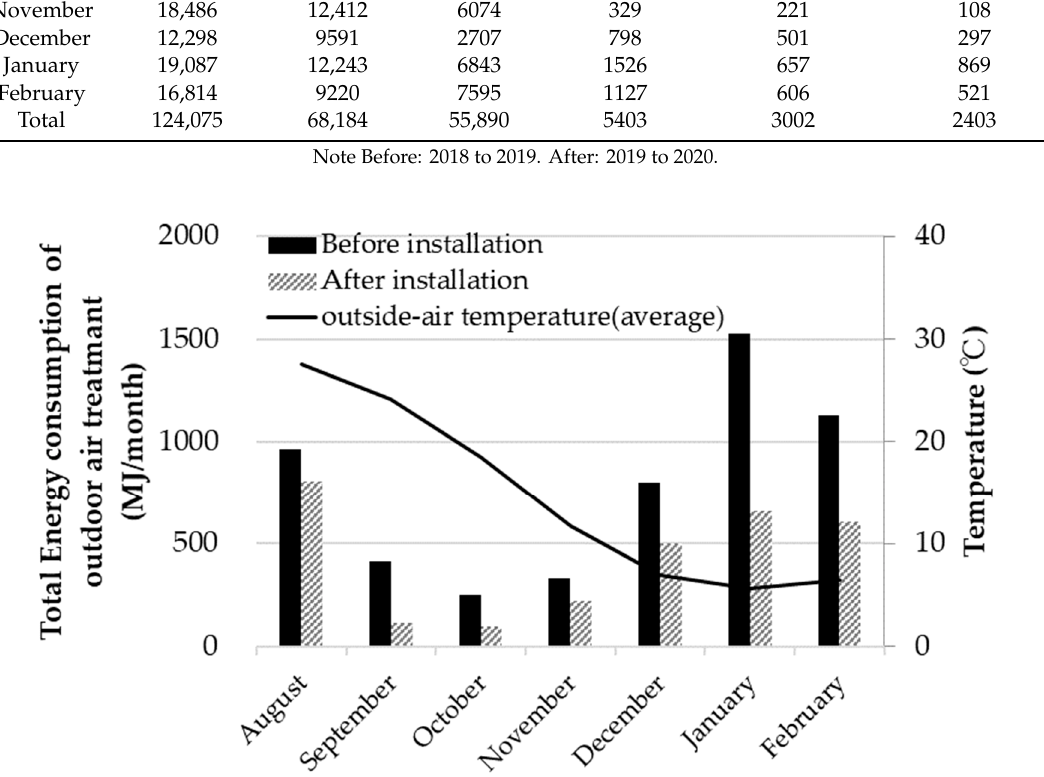
Figure 6. Energy consumption before and after installation. Note: Outside-air temperature values